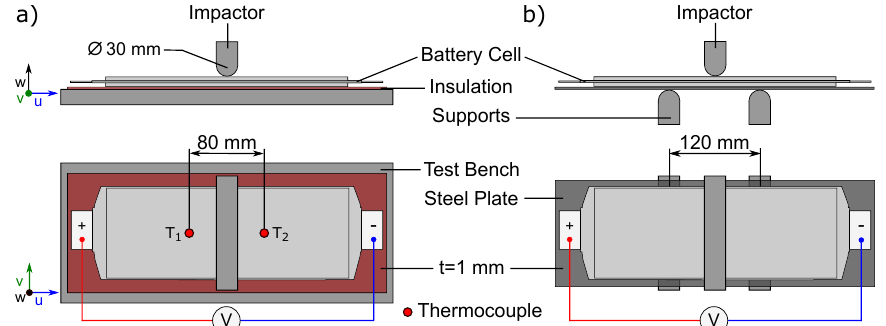
Figure 2. Experimental setup of the mechanical cell tests: ( a ) Shows the cylindrical indentation test setup including test bench, insulation plate, cylindrical impactor ( ∅ 30mm), and the investigated battery cell. ( b ) Shows the three-point bending test setup with a supporting S235JR steel plate for a realistic cell deformation and two cylindrical supports at a distance of 120mm ( ∅